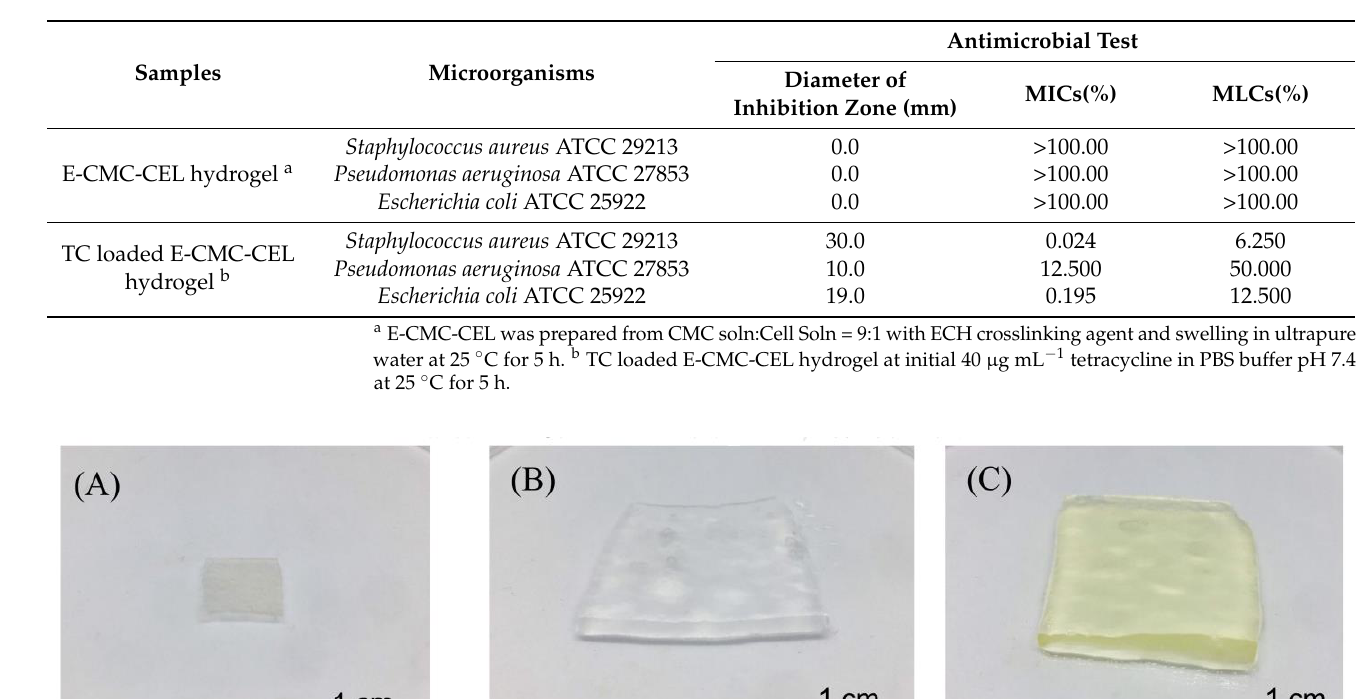
Table 1. Antimicrobial activity test of tetracycline loaded E-CMC-CEL and swelled E-CMC-CEL hydrogels.